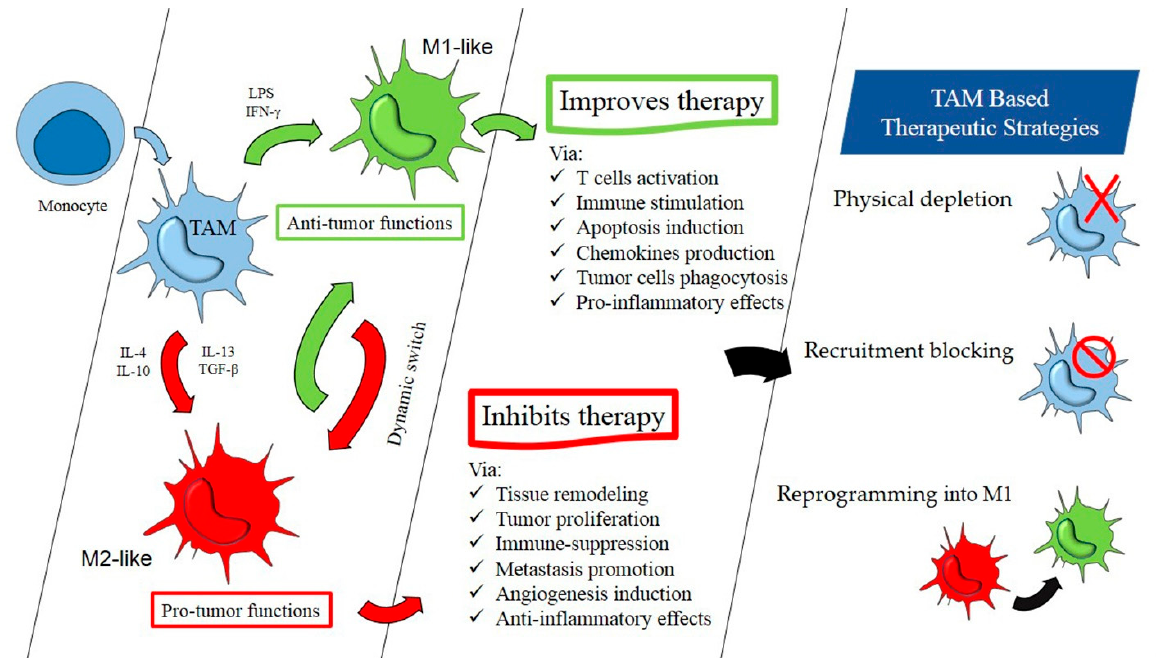
Figure 2. M1- and M2-like macrophage significance in cancer treatment.